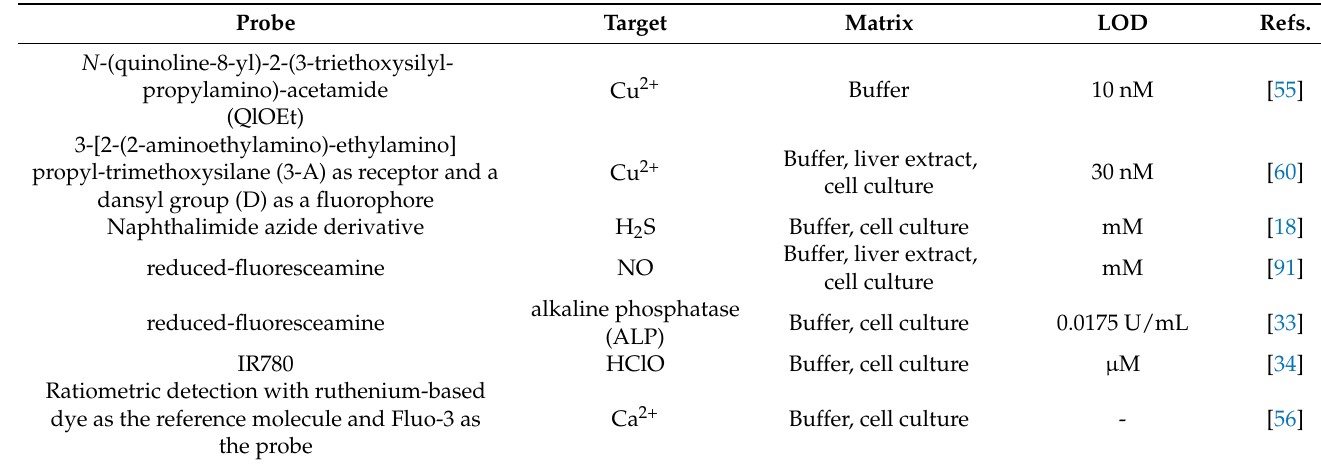
Table 1. Si NW as a substrate coupled with